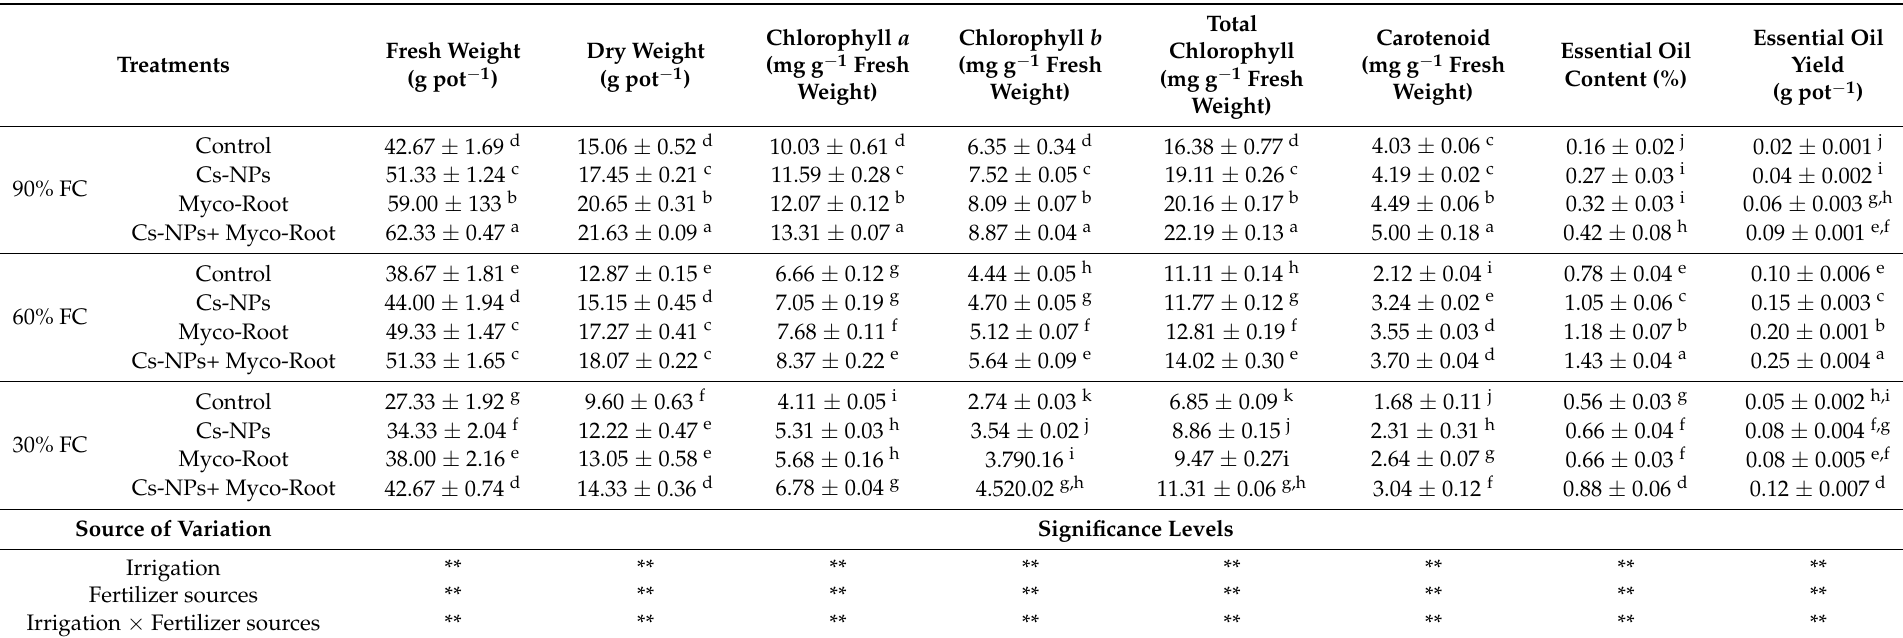
Table 1. Fresh weight, dry weight, essential oil content, essential oil yield, chlorophyll a , chlorophyll b , total chlorophyll and carotenoid content of L. iberica influenced by different fertilizer resources and irrigation